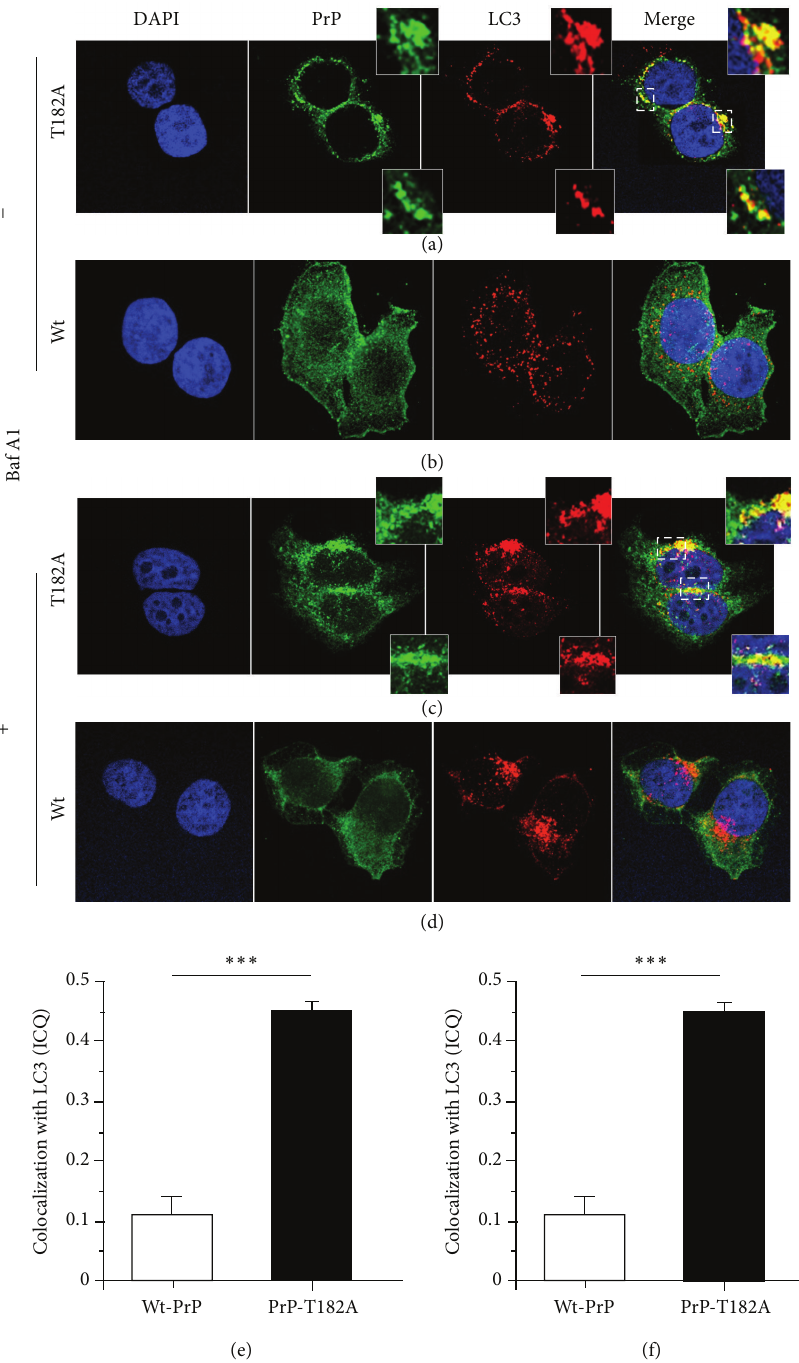
Figure 7: Mut-PrP colocalizes with autophagosomes. Confocal immunofluorescence of HeLa cells stably expressing GFP-tagged Mut- (a, c) or Wt- (b, d) PrP before ( − ) and after (+) incubation for 6h with 50 nM Baf A1. Cells were fixed with 4% paraformaldehyde for 15min, permeabilized with 0.1% Triton X-100 for 5min, then stained with anti-LC3B antibody and DyLight 649-conjugated Affini-Pure goat anti- rabbitIgG,priortoinvertedconfocalfluorescencemicroscopyimagingusingaMarianasYokogawatypespinningdisk(originalmagnification, x100). Li’s method (NIH Image J plugin) was applied to determine the degree of colocalization of PrP::GFP (green) and LC3B (red). Graphs display the intensity correlation quotient (ICQ), which ranges from − 0.5 (no correlation of signals) to 0.5 (complete correlation), between LC3B and Wt- or Mut-PrP in the absence (e) or presence (f) of BafA1. ( ∗∗∗ 𝑃 < 0.0001 ). There were no differences in any values between those treated with BafA1 and control cells. Actual values are (e) BafA1( − ) Wt-PrP = 0.110 ± 0.06 , Mut-PrP = 0.450 ± 0.023 , (f) BafA1(+) Wt-PrP = 0.117 ± 0.038 , Mut-PrP = 0.447 ± 0.015 , 𝑛 = 10 cells